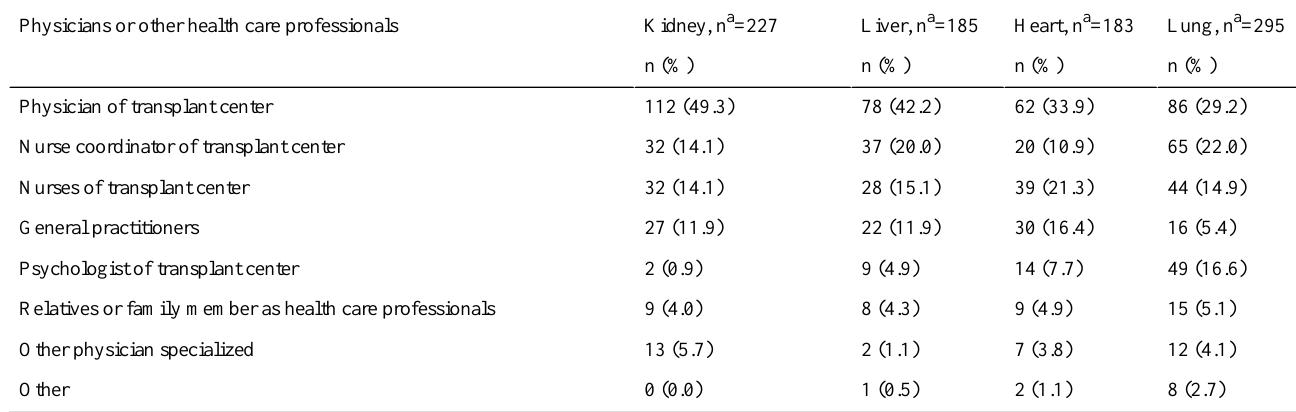
Table 2. Distribution of information sources provided by physicians or other health care professionals for patients of each type of transplantation ( P <.001).